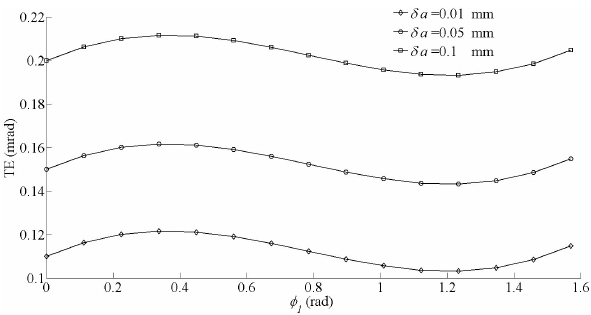
Figure 6. TEs of the improved NHGM with different center dis- tance